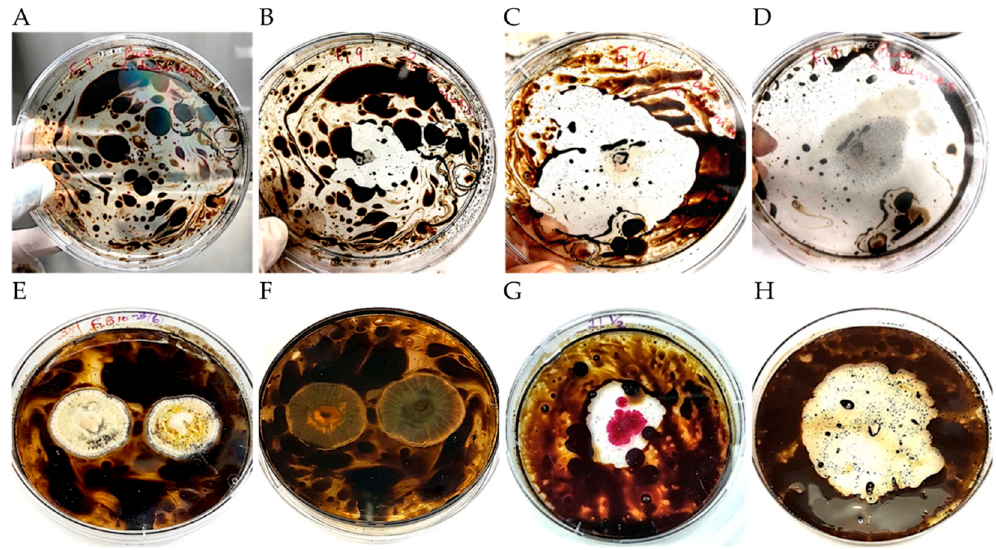
Figure 2. Bioassay on crude oil-amended plates. Examples of oil-degradation/utilization for ( A ) Lecythophora sp. (yeast) at 0 h; ( B ) Lecythophora sp. at 24 h; ( C ) Lecythophora sp. at 72 h; ( D ) Lecythophora sp. at 120 h; ( E ) Aspergillus sp. (filamentous fungus) front view at 7 days; ( F ) Aspergillus sp. with the disappearance of oil seen on the reverse view of the colony at 7 days; ( G ) Serratia sp. (bacterium) at 72 h; ( H ) Janthinobacterium sp. (bacterium) at 72 h. Table 3. Minimum, maximum, mean absolute abundance, and Fisher’s pairwise comparison ac- cording to media type and sites.